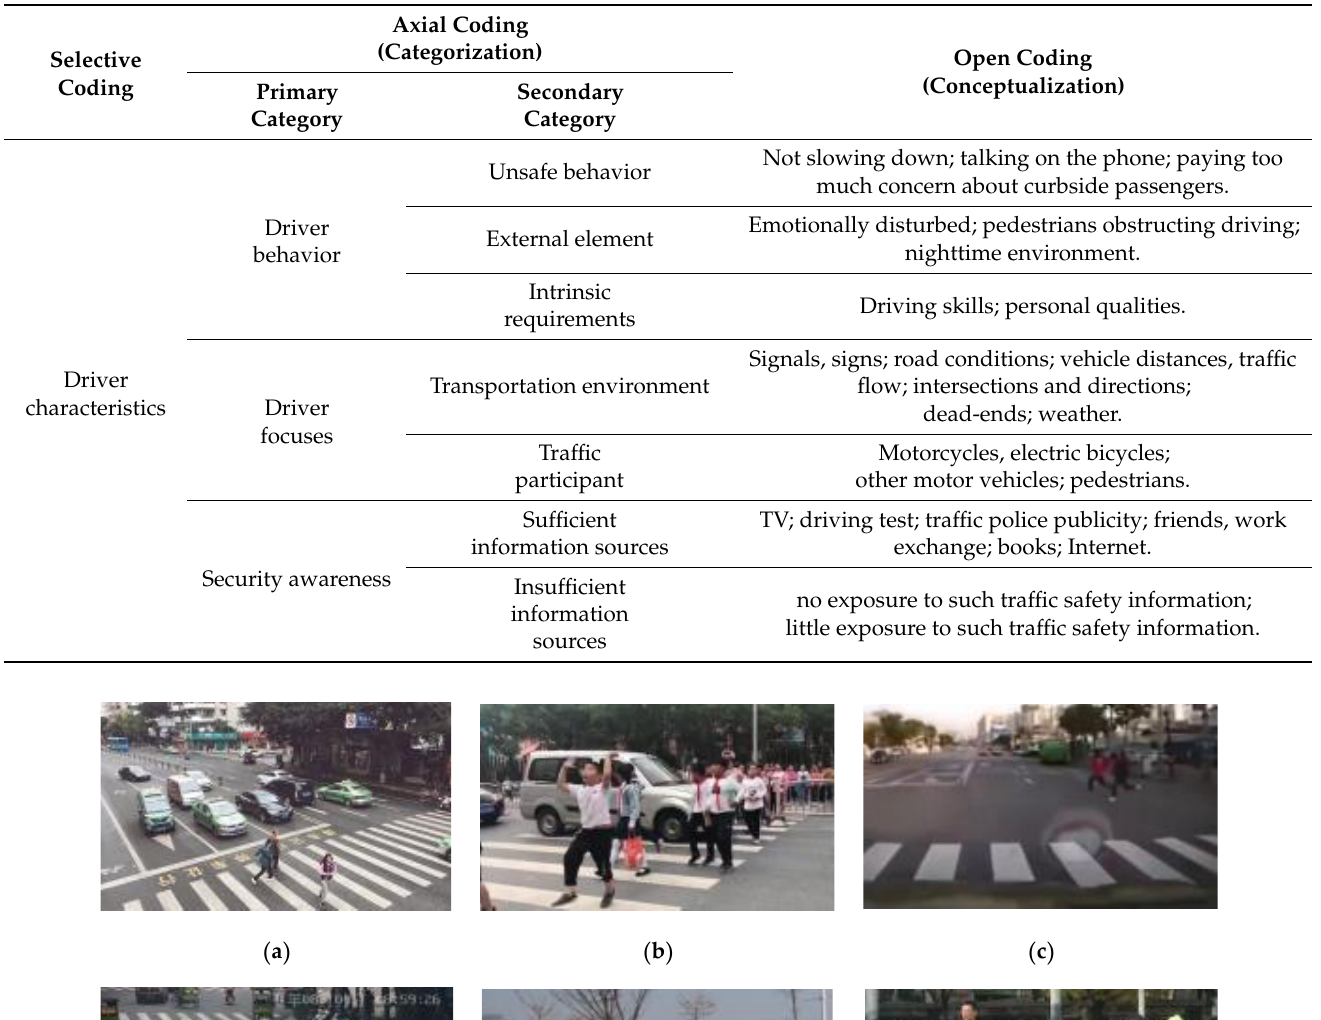
Table 4. The three-level coding (axial coding with two categories) process of interview data.